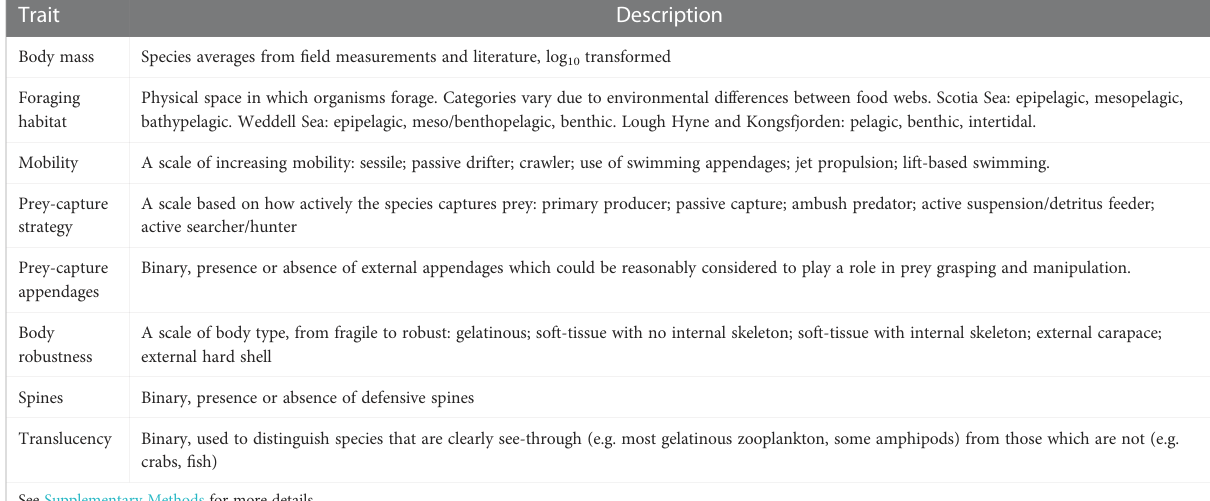
TABLE 2 Functional traits identi fi ed for each species in the four food webs. Trait